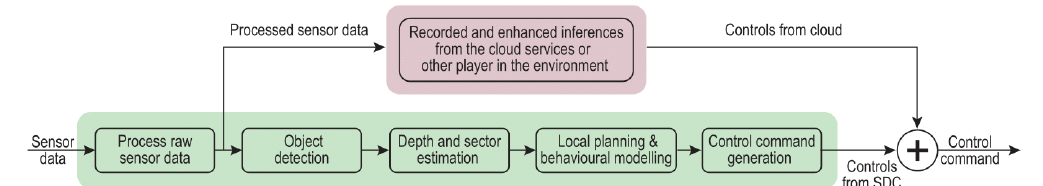
Figure 8. Bypassing the processing stack by making a request to the clouds or other agents in the net- work for the control commands corresponding to the events encountered by the autonomous